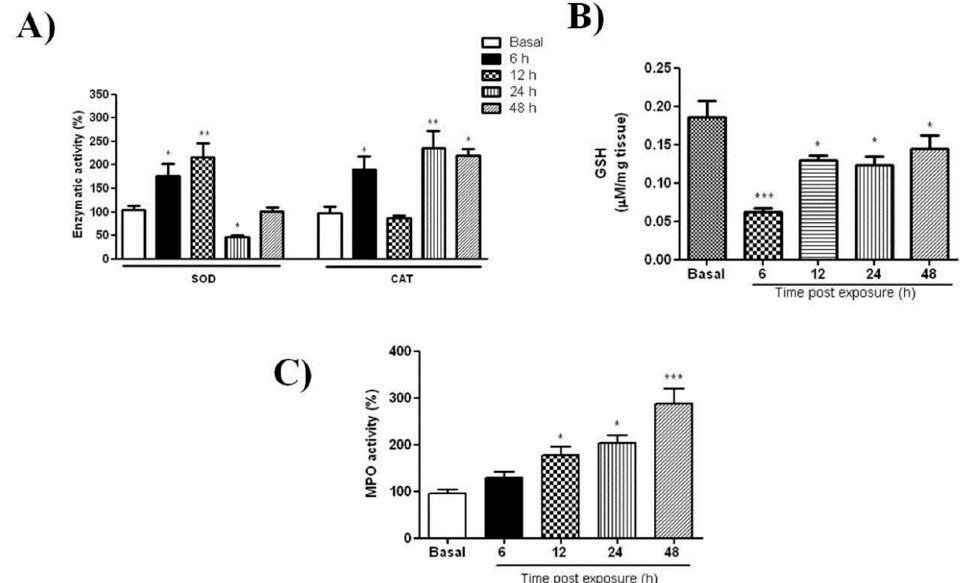
Figure 2. Antioxidant mediators following skin UVB-radiation. Dorsal skin was exposed to a single dose of UVB (2.4 J cm − 1 ) and changes were analyzed at di ff erent intervals. Activity profiles